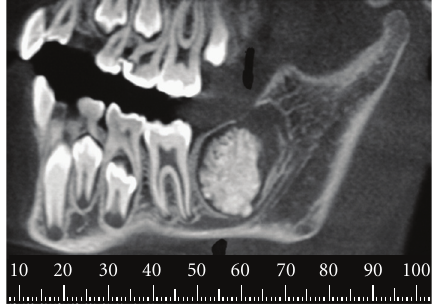
Figure 5: (H.E.): Dentin (d) and enamel matrix